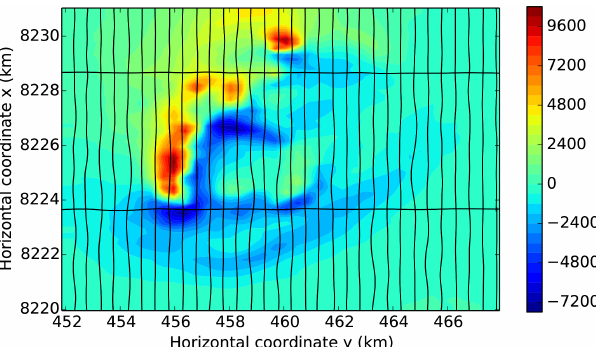
Figure 17. Application to field data on the Goiás alkaline province (GAP), Brazil. Total-field anomaly observed over the Montes Claros de Goiás alkaline complex (Fig. 14). The flight lines of the aeromagnetic survey are shown in black. The magnetic data are in nT and the coordinates are in UTM on the SAD-69 datum, with central meridian 51 ◦ W. The origins of the eastern and northern co- ordinates are 500 and 10000km, respectively.